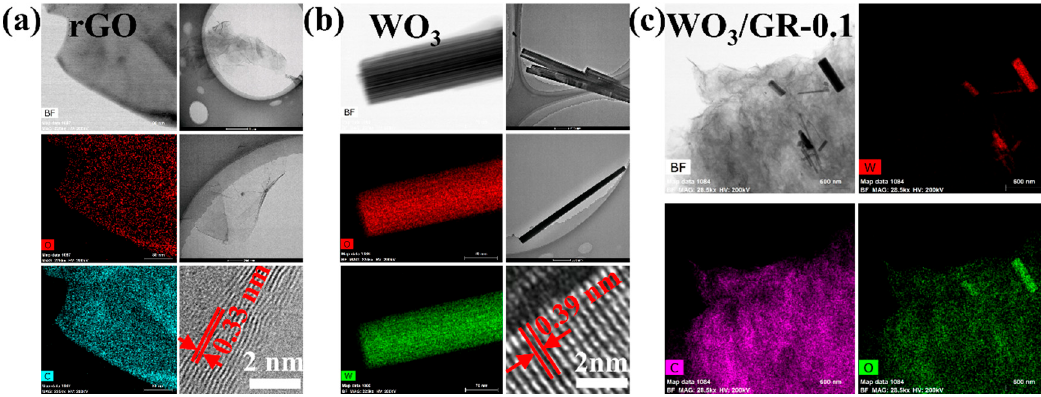
Figure 6. Bright-field TEM-EDS showing the microstructure and composition of: ( a ) rGO; ( b ) pure WO 3 ; and ( c ) the WO 3 /GR-0.1 nanocomposite.